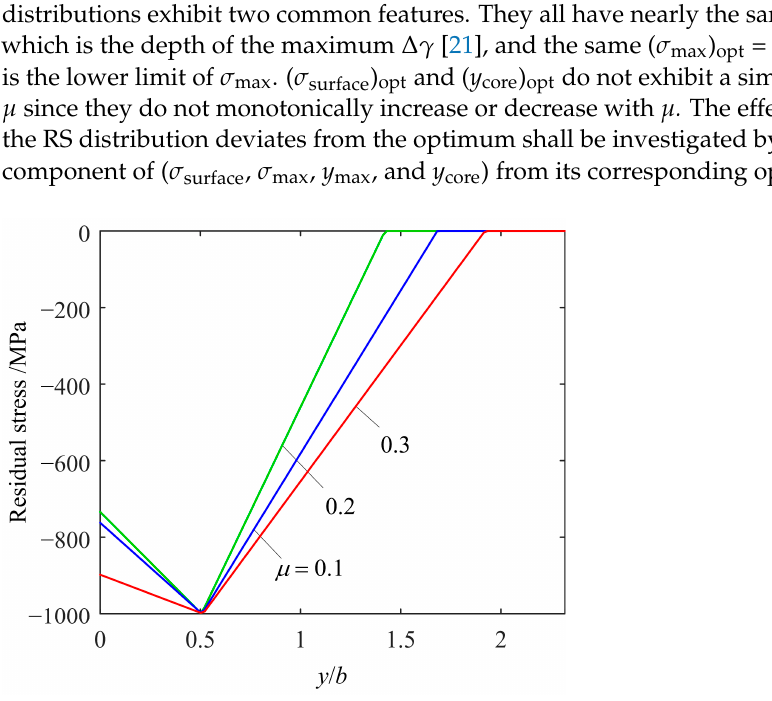
Figure 11. The percentage decrease in ( N f ) min when ( a ) y max and ( b ) y core deviate from their optimum values for P / P rated = 1 and μ = 0.1, 0.2, and 0.3.